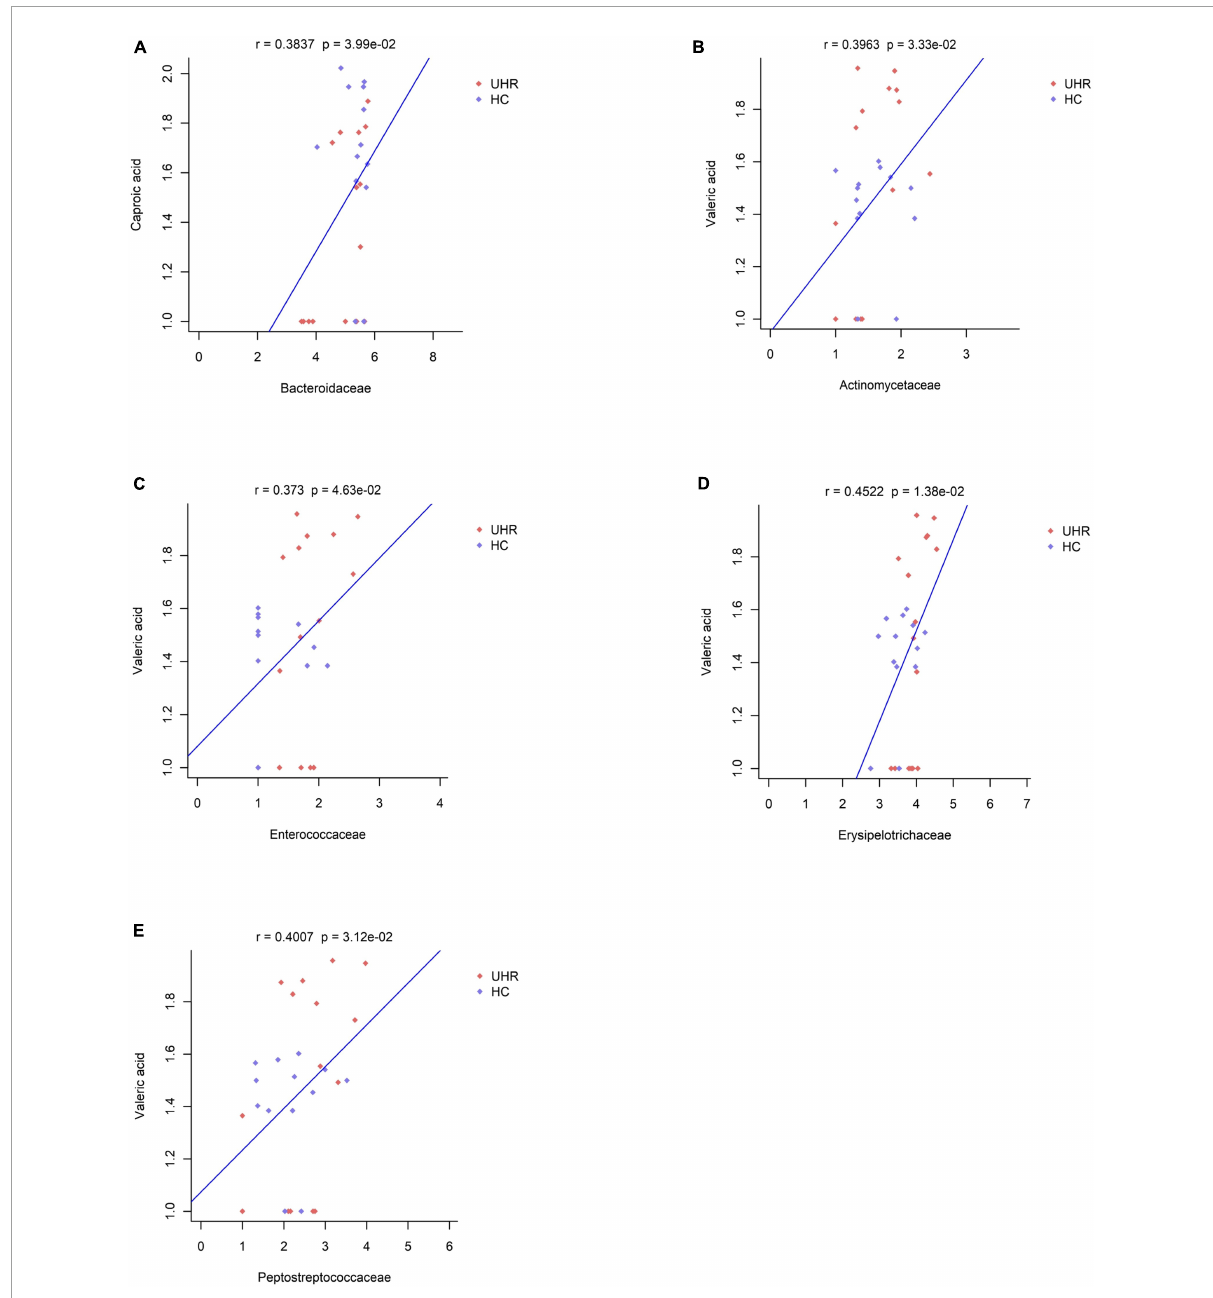
FIGURE5 Correlation between serum short-chain fatty acids (SCFAs) and the abundance of fecal Peptostreptococcaceae , Enterococcaceae , Erysipelotrichaceae , Actinomycetaceae , Bacteroidaceae at family level. (A) Showed the correlation between caproic acid level and the abundance of Bacteroidaceae . (B–E) Showed the correlation between valeric acid level and the abundance of Actinomycetaceae , Enterococcaceae , Erysipelotrichaceae , and Peptostreptococcaceae ,